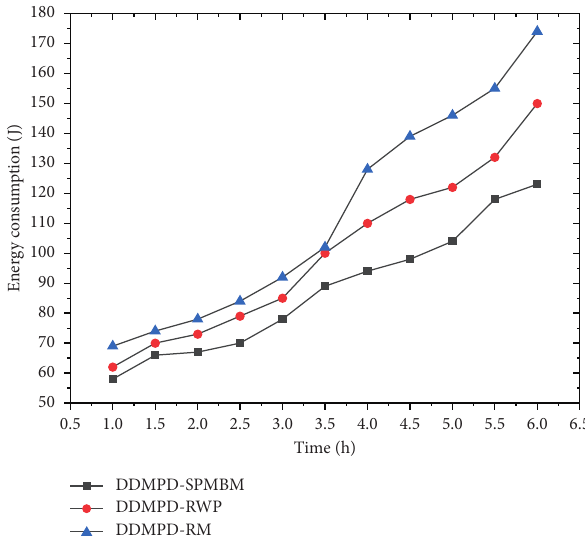
Figure 15: Relationship between delivery ratio and time in three mobile models.